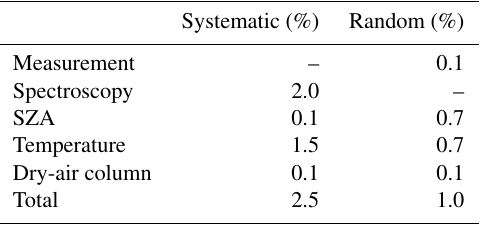
Table 2. The systematic and random uncertainties for NDACC re- trieved X CO at Saint-Denis. “–” means that the uncertainty is less than 0.1 and then can be ignored. The total uncertainties are calcu- lated by adding the sub-types in